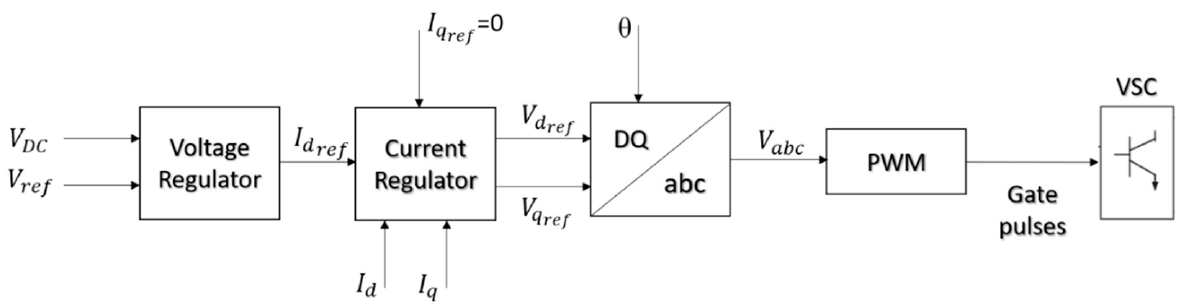
Figure 7. VSC voltage and current control.